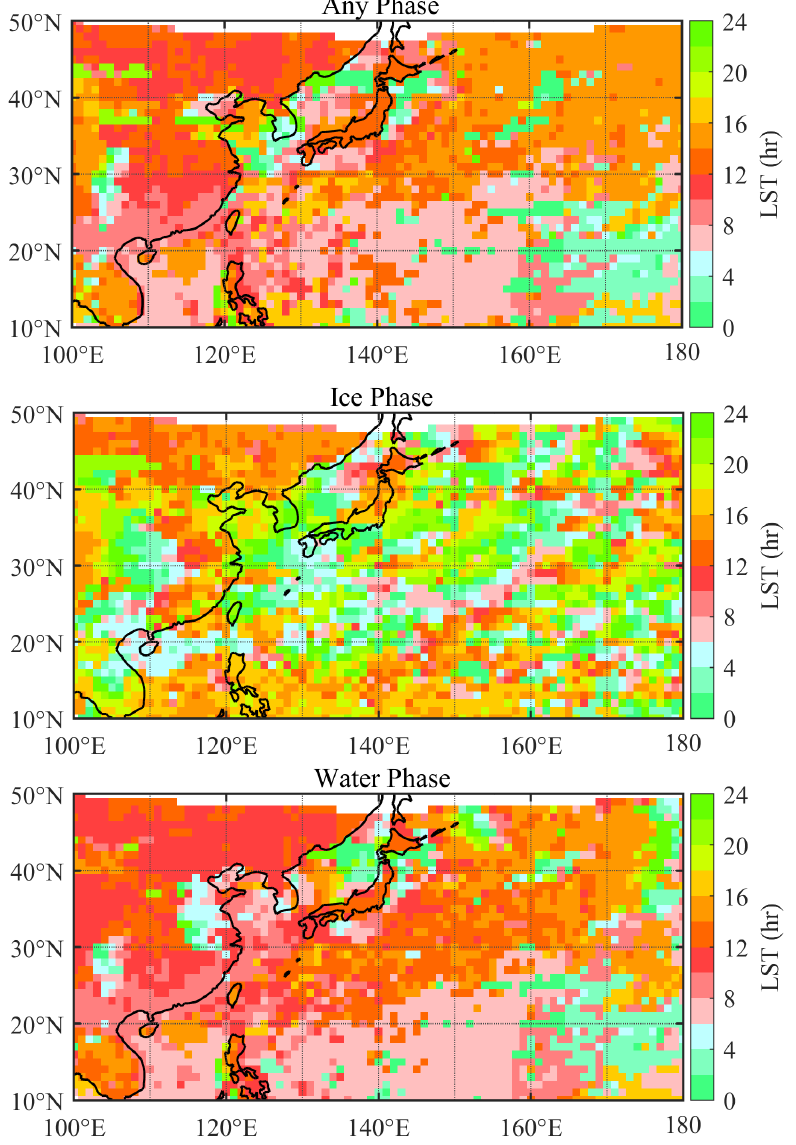
Figure 10. Same as Figure 9 except using the 3-year boreal winter data. Figures 11 and 12 provide the diurnal variations in the frequencies of ice, water, and supercooled water phases over the nine regions of interest. The diurnal variations are significant for ice phase over R8 during summer and water phase over R6 during winter. The small amplitudes over the ocean are possibly due to the large heat capacity of water. Note that the diurnal variations for water clouds always have shallow troughs appearing around 0700 and 1700 LST. This feature is caused by the artifacts of the AHI cloud mask algorithm, as mentioned in Section